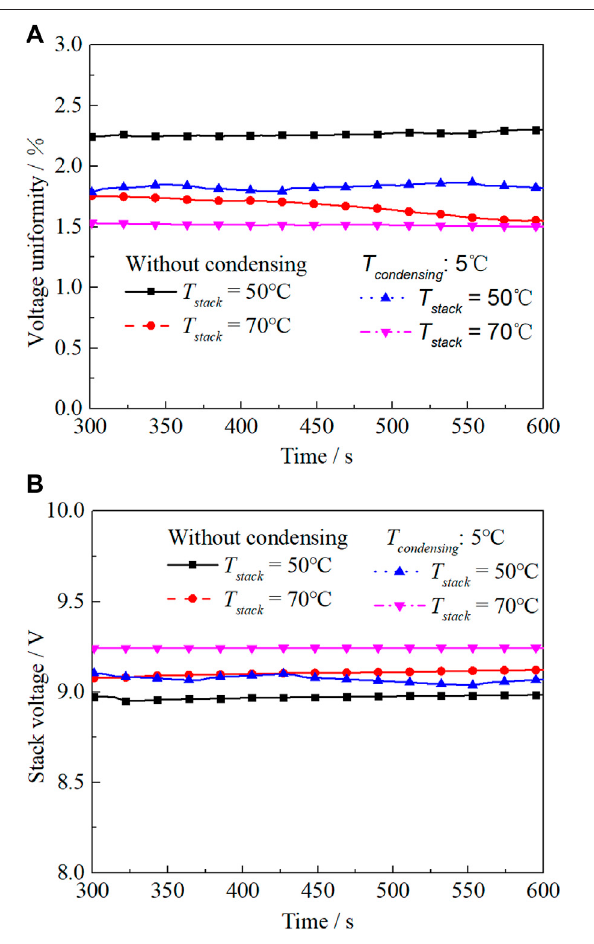
FIGURE 4 | Performance comparison (A) Voltage uniformity, (B) Stack